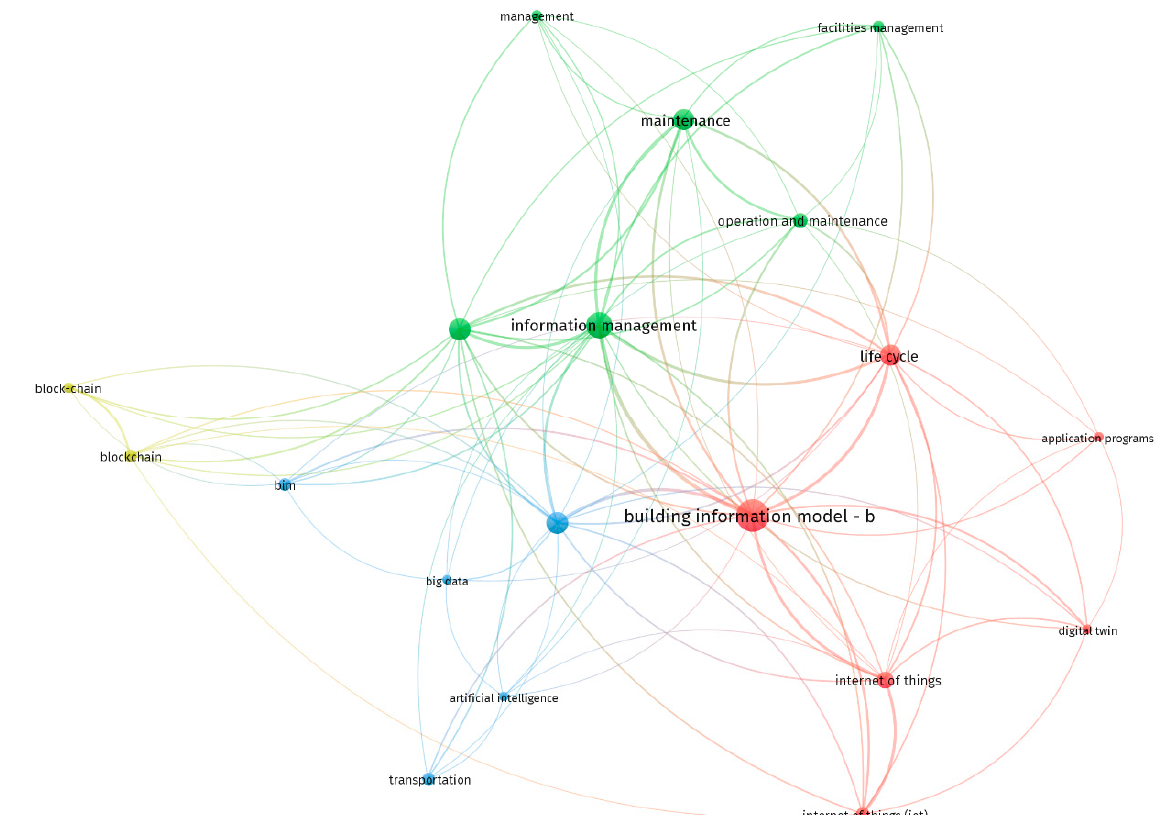
Figure 2. Network of the main keywords of the referenced articles. Made with